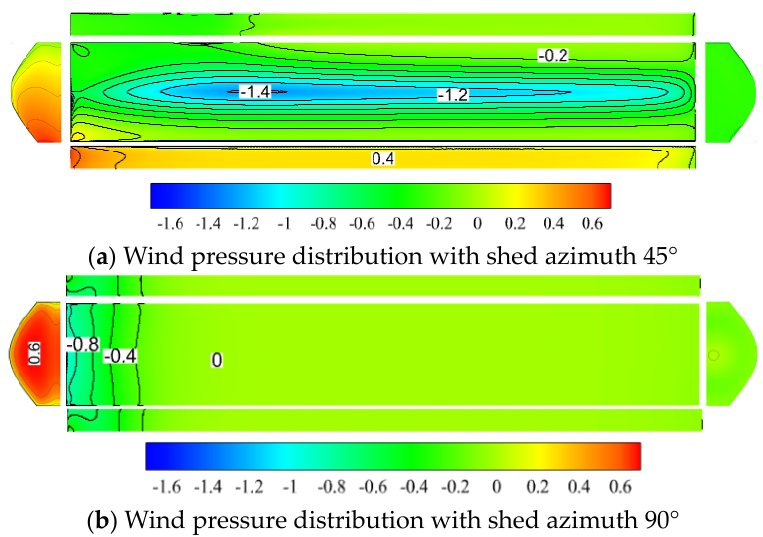
Figure 10. Distribution of wind pressure on single-span arched shed in a plain area.